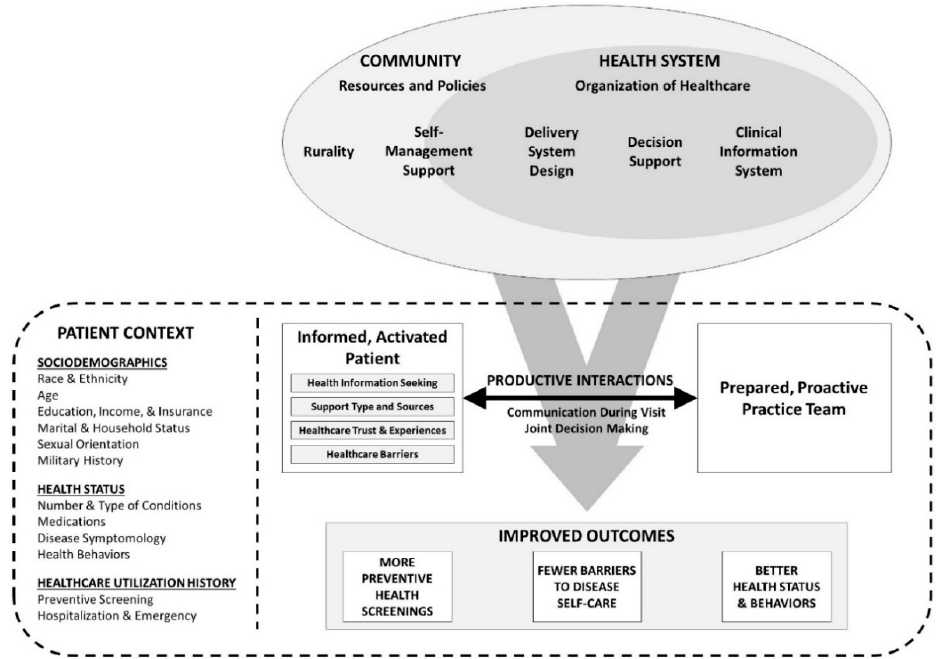
Figure 1. Modified Chronic Care Model Accounting for Patient Context.